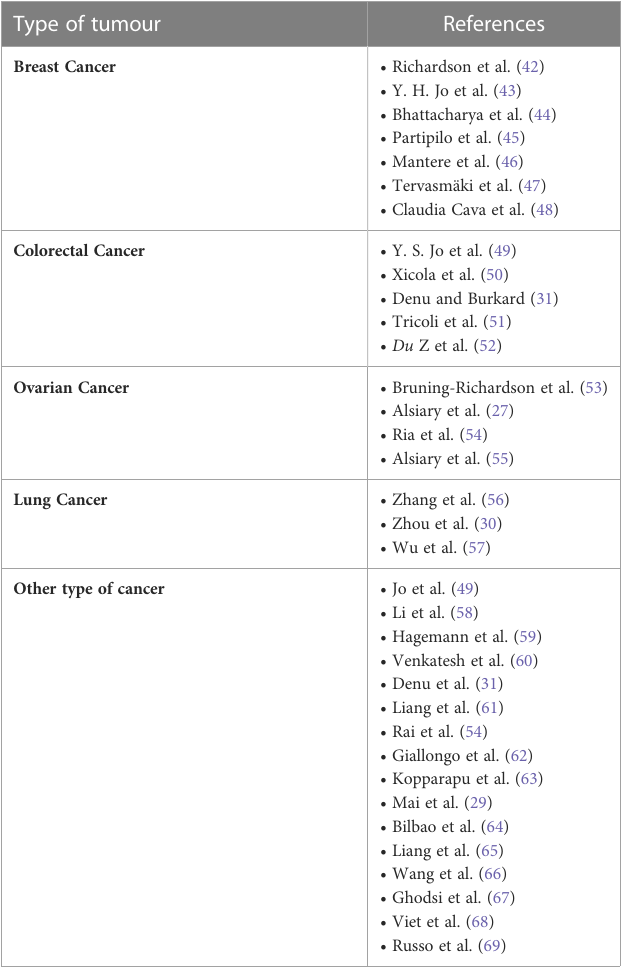
TABLE 2 Summary of studies on MCPH1/BRIT1 in human